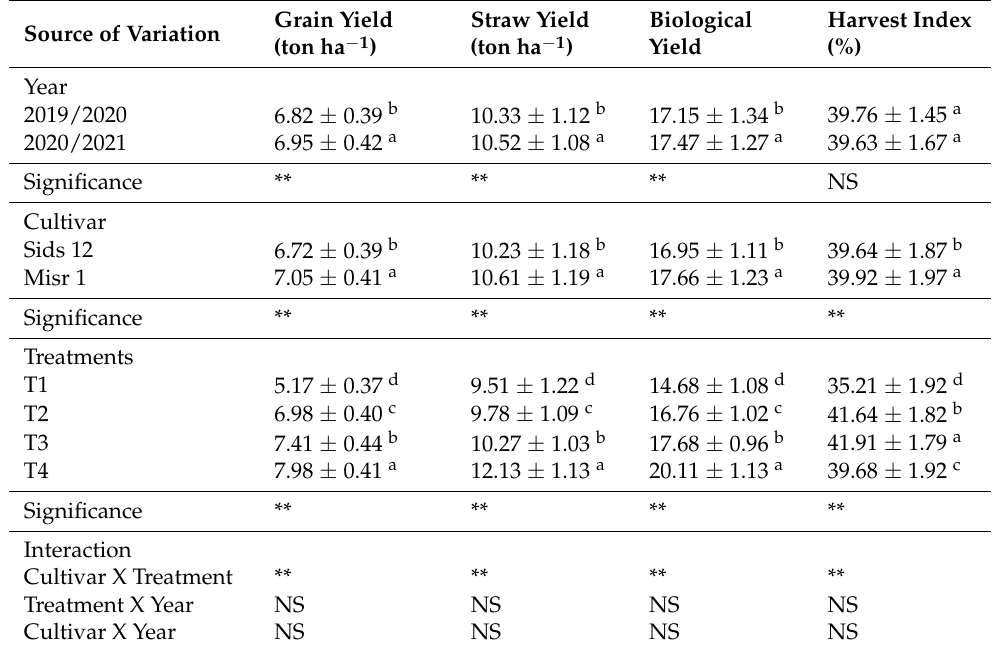
Table 5. Impact of different treatments (EM, CT, and combination) on the yield and yield component of wheat 70 days after sowing during the two growing